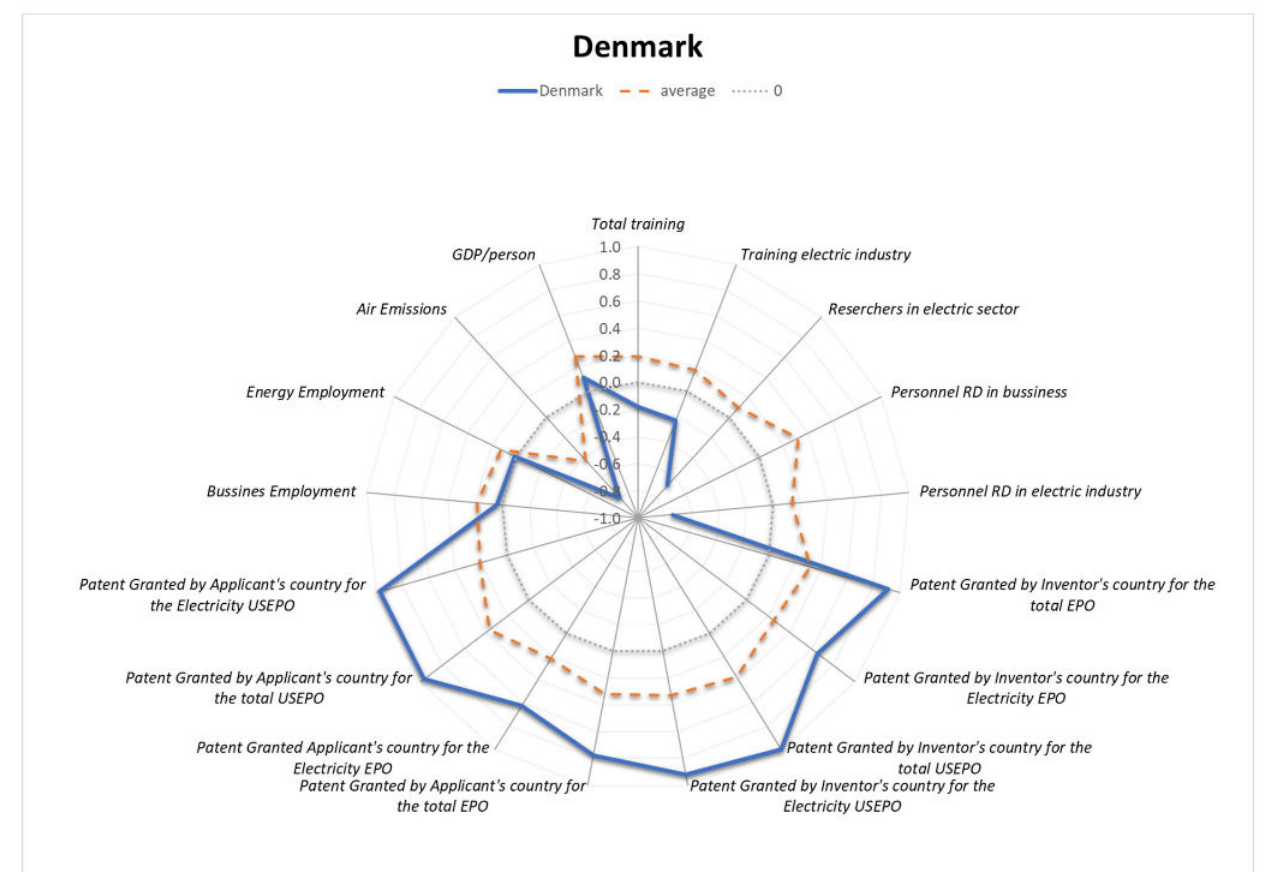
Figure 14. Synergy and trade-off occurrence—DK. Source: Authors’